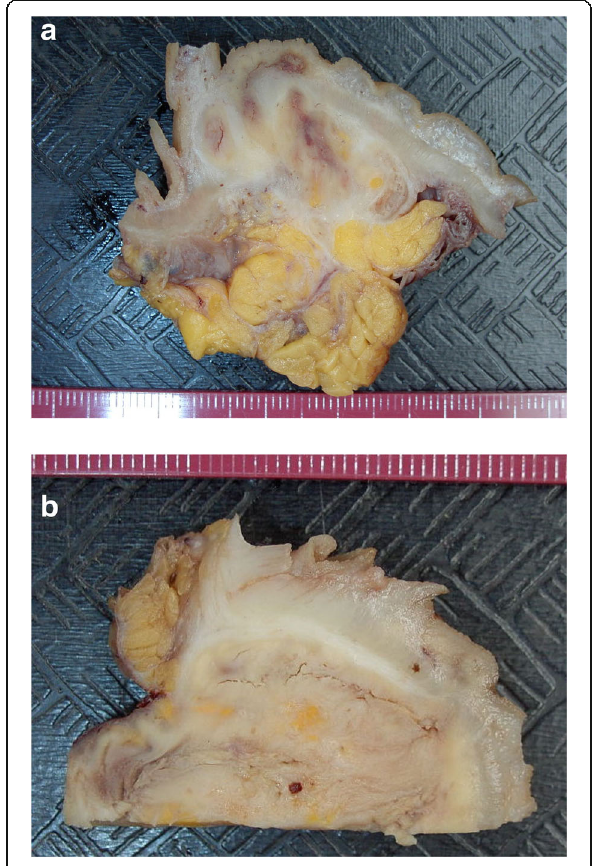
Fig. 2 Macroscopy of the resected sigmoid. a and b In both images the mucosa is at top. The underlying bowel wall and mesentary are infiltrated and distorted by malakoplakia infiltrates which are friable and have visible cracking artefact